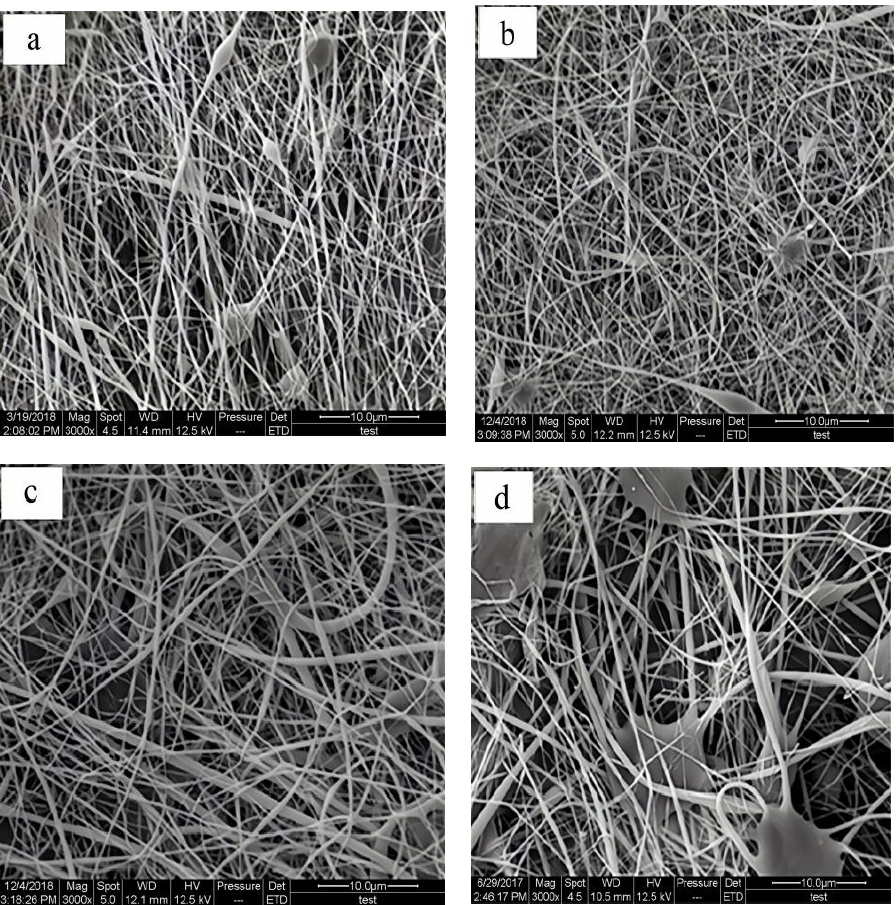
Figure 12. SEM images at different addition of FeCl 3 ·6H 2 O: ( a ) the addition of 0.4 wt%; ( b ) the addition of 0.8 wt%; ( c ) the addition of 1.2 wt%; ( d ) the addition of 1.6 wt%.